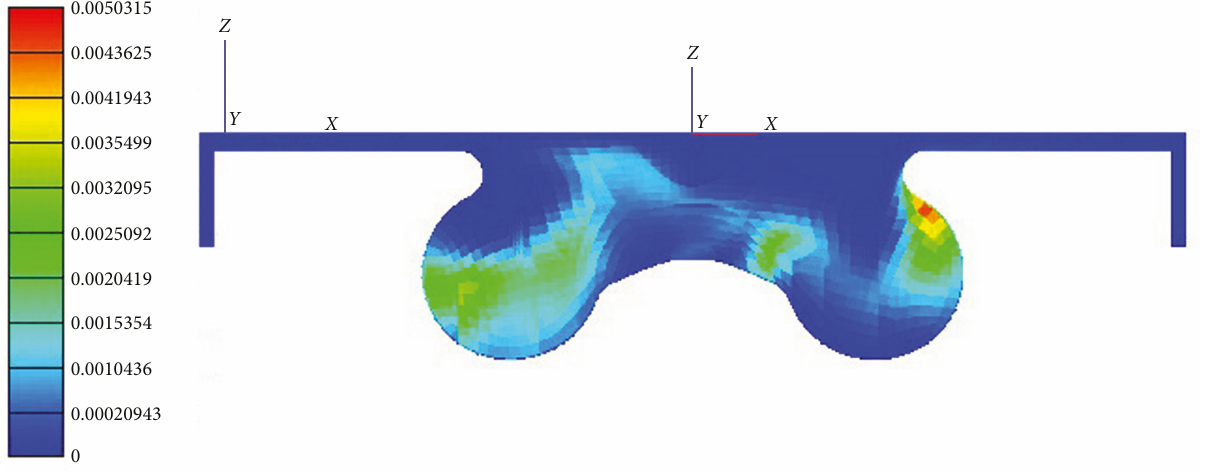
Figure 9: The distribution of NO